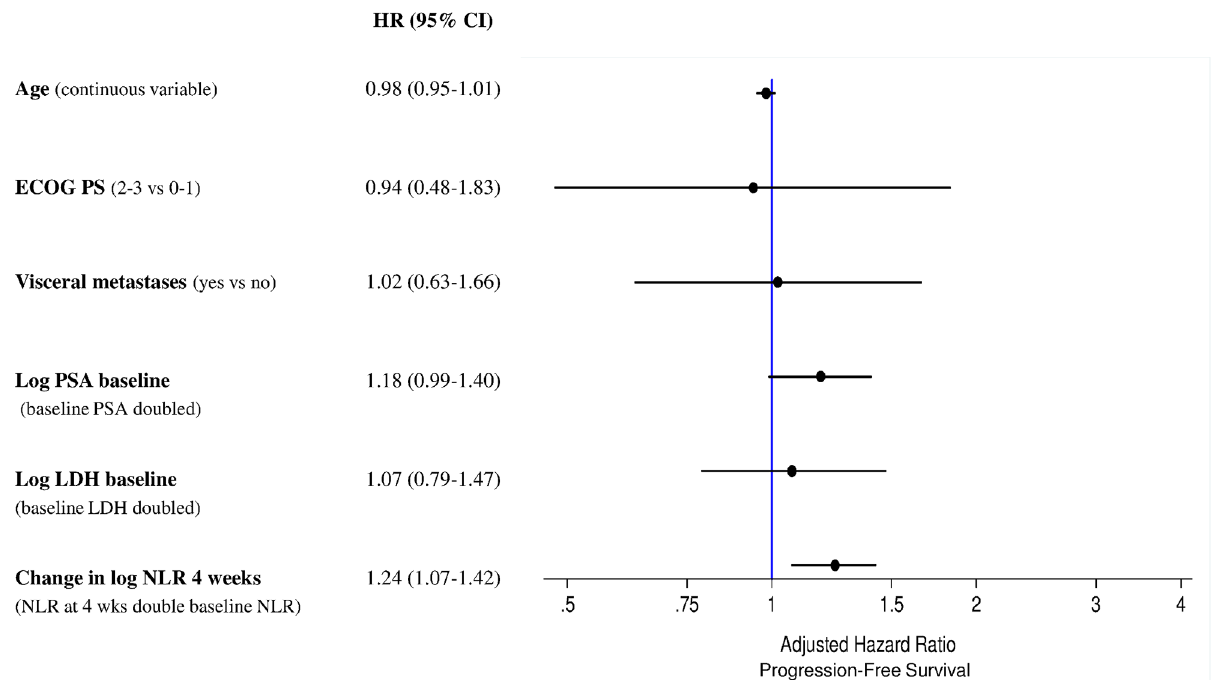
Fig 1. Forest plot for progression-free